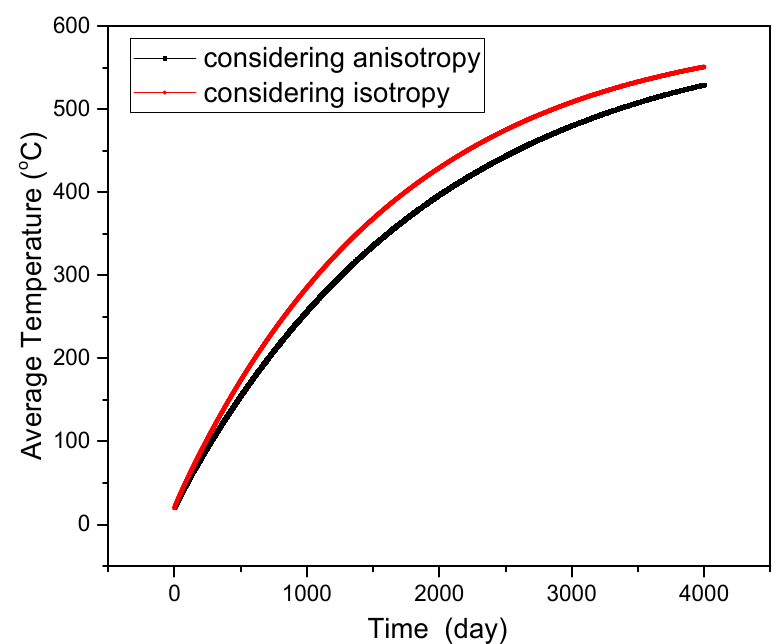
Figure 14. Variation of the oil shale reservoir’s temperature with heating